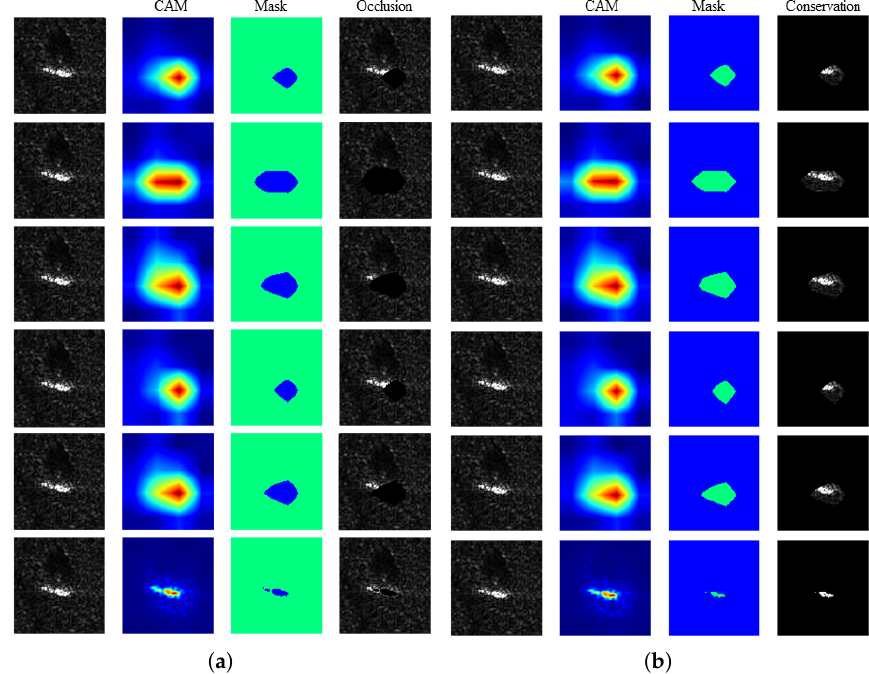
Figure 4. Results of occlusion and conservation. ( a ) The occlusion results for a SAR image. The six rows correspond to Ablation-CAM, Score-CAM, Grad-CAM, Grad-CAM++, XGrad-CAM, and Self-Matching CAM. The four columns denote the original image, CAM heatmaps, binary mask, and occluded image. ( b ) The conservation results of the SAR image. The organization of subfigures is the same as for ( a ).